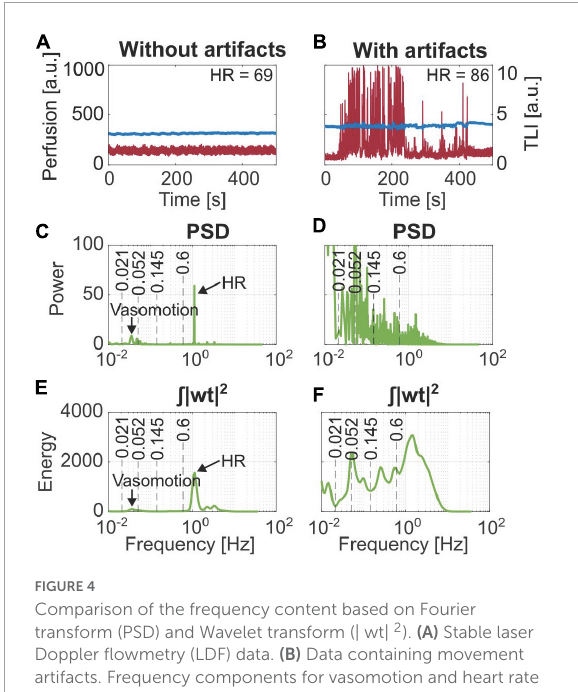
FIGURE5 Wavelet scalogram of the perfusion signal and time-resolved wavelet energy in the 0.5–0.6 Hz frequency band of a 2-h laser Doppler flowmetry (LDF) time series, showing